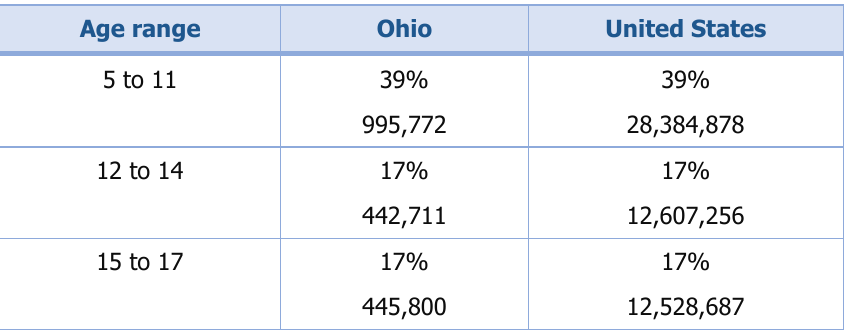
Table 1. Percent and Frequency of Age Distribution in Ohio and United States